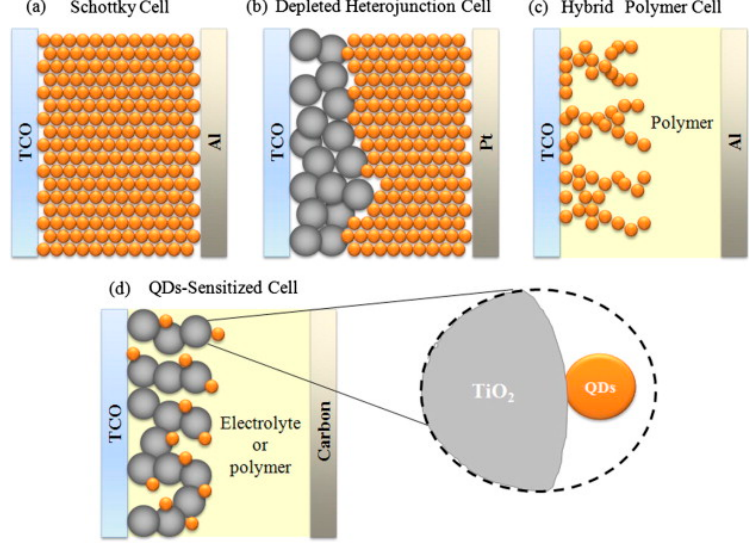
Figure 2. Different quantum dot-based photovoltaic cells. From [41], reprinted with permission. Copyright © Elsevier 2011.